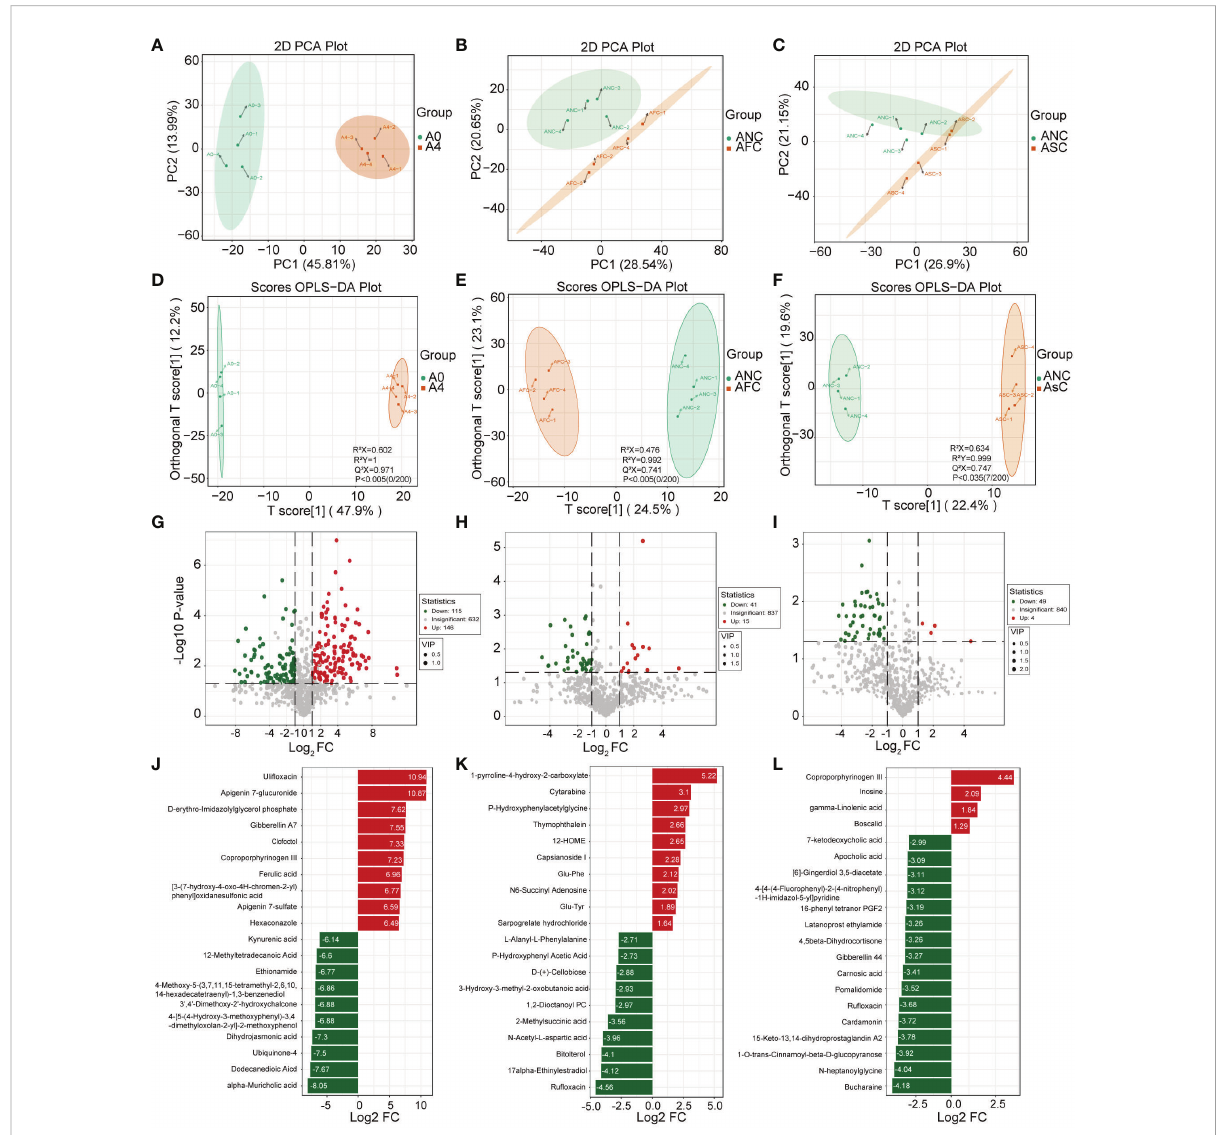
FIGURE 7 The role of fecal microbiota transplantation (FMT) and short-chain fatty acids (SCFAs) in fecal metabolism in mice with sepsis. (A – C) The Scatter plot of principal components analysis (PCA) for metabolites shows that the A0 group had a very different metabolic pro fi le than the A4 group. (D – F) OPLS-DA analyses of the metabolite pro fi le. OPLS-DA scores plot and OPLS-DA model test chart showed good discrimination between the groups. Volcano Plot showing differential metabolites between the A0 and A4 groups (G) and between the ANC and AFC groups (H) , and between the ANC and ASC groups (I) . Linear discriminate analysis (LDA) effect size analysis of the top 20 differential metabolites between the A0 and A4 groups (J) and between the ANC and AFC groups (K) , and between the ANC and ASC groups (L) . LDA scores > 1 and signi fi cance of p < 0.05 as determined by Wilcoxon ’ s signed-rank